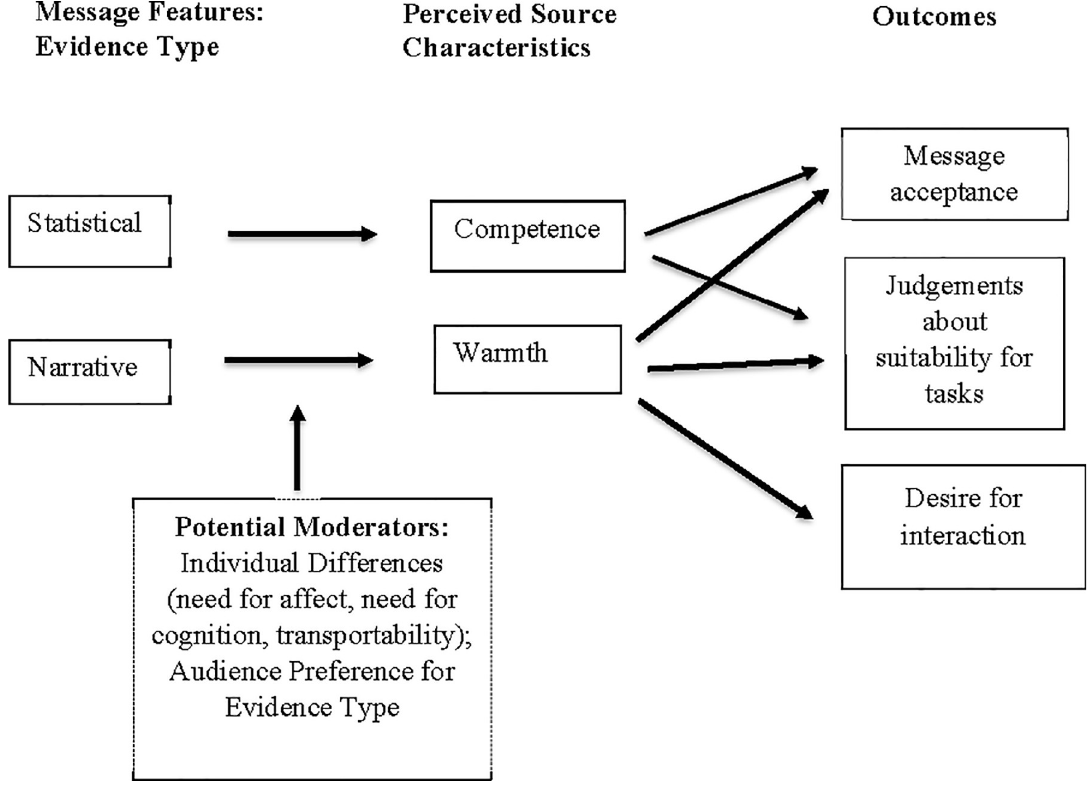
Fig 1. Message-based impression formation